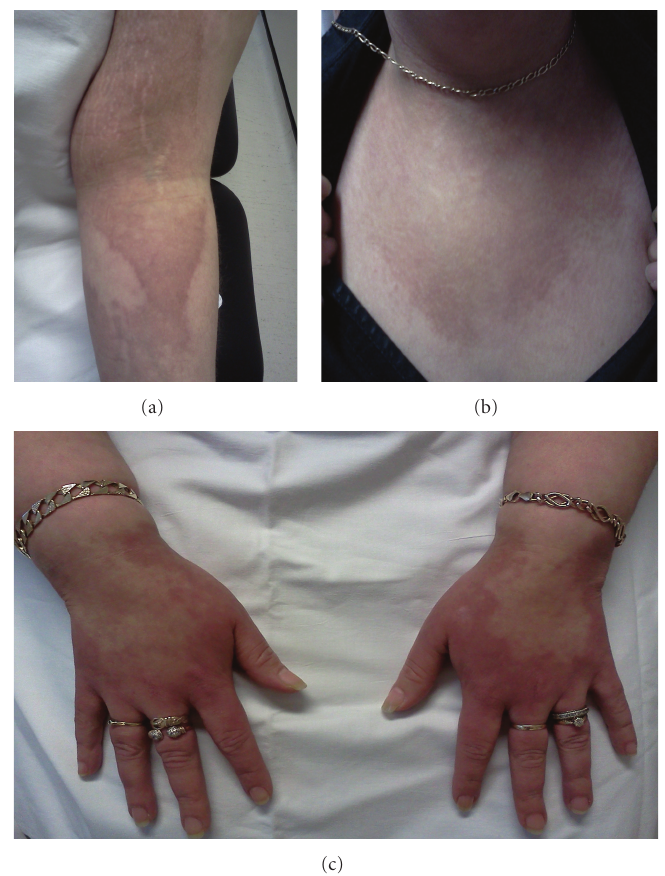
Figure 1: Atrophic eruption a ff ecting (a) flexures of arms, (b) upper chest, and (c) hands.